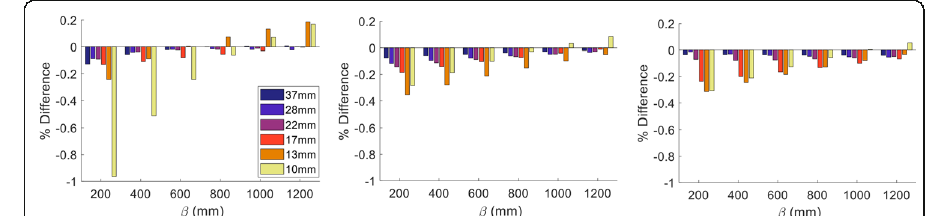
Fig. 5 Percentage difference of RC max (left), RC mean (middle) and RC peak (right) between BPL β and PSF 6.4 − RC PSF Þ = RC PSF (cid:2) for all spheres. Each group of bars corresponds to the comparison reconstruction [( RC BPL β 6 : 4 6 : 4 with a single β value (200, 400, 600, 800, 1000 and 1200)